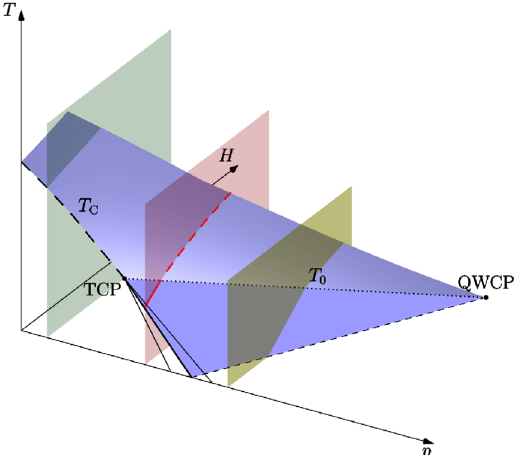
immediate vicinity of the tricritical point (TCP) in the temperature ( T ) — magnetic fi eld ( H ) — control parameter ( p ) space based on the experimental data. Within presented study, the control parameter is either hydrostatic pressure or substitution. Starting at high temperatures and H = 0 the second order transition is indicated by dashed line , spreading to non-zero fi eld as second order transition plane ( light blue surface ). Below TCP ( H = 0, solid line ) and crossover temperature T 0 for H ≠ 0 ( dark blue ) the transition becomes fi rst order accompanied by the presence of hysteresis (for simplicity indicated only for H = 0). Planes for fi xed p indicate position of samples used in this study — green (UCo 0.990 Ru 0.010 Al), red (UCo 0.995 Ru 0.005 Al) and brown (UCoAl). The red line indicate the phase transition line ( μ 0 H c ) for the UCo 0.995 Ru 0.005 Al as shown in Fig. 3, indicating both fi rst-order ( solid ) and second-order ( dashed ) transition. For simplicity, the phase boundaries are sketched only